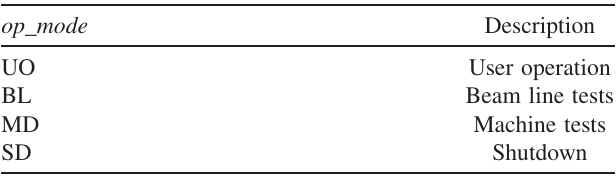
TABLE I. SLS operation